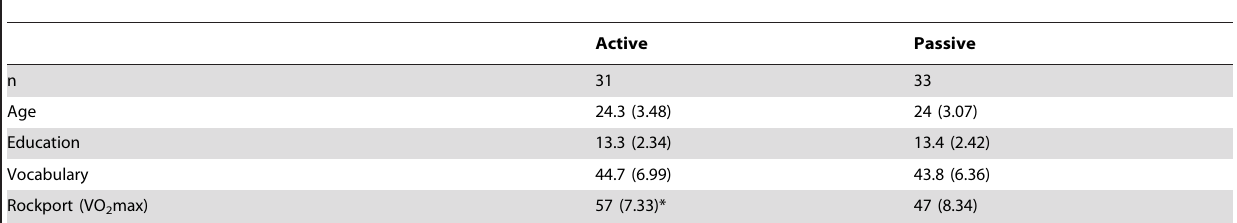
Table 1. Demographic Variables (Means and SDs) and Rockport Test, * p , .01.